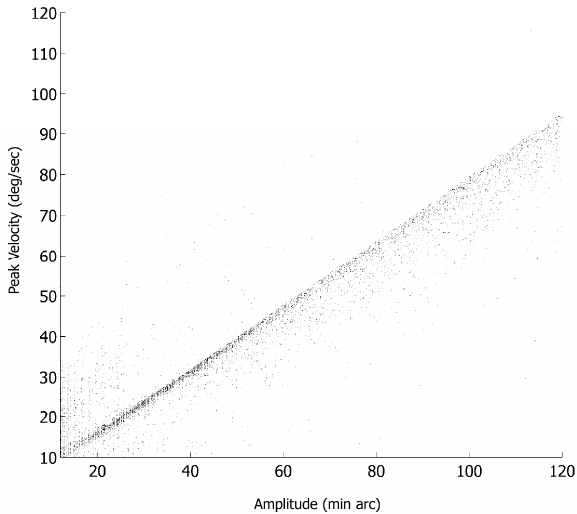
Figure 2. The main sequence plot for monkey A collapsed over all visual cueing experiments. The expected linear relationship between amplitude and peak velocity was observed.